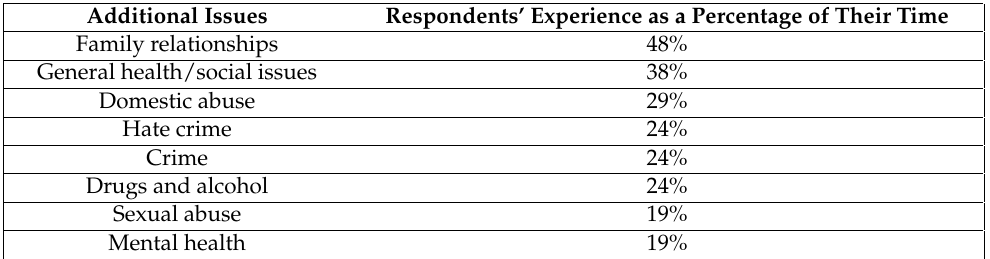
Table A1. Proportion of issues dealt with in addition to traditional Imam